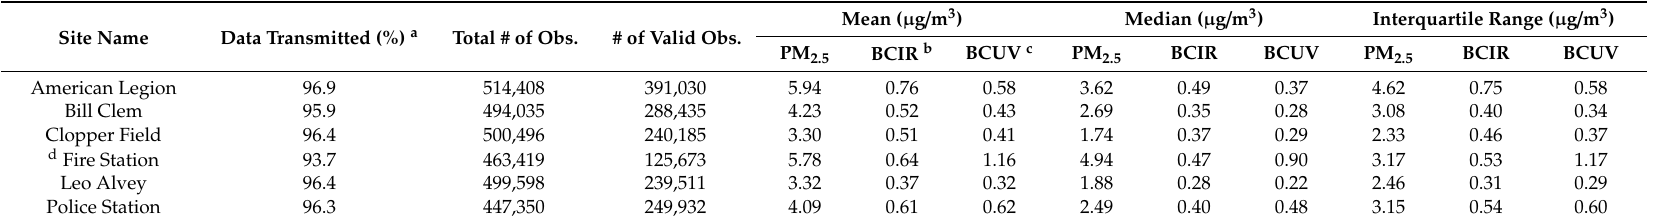
Table 6. Site-Specific Summary Statistics for the 1-min P-POD Data, (24 October 2017–31 October